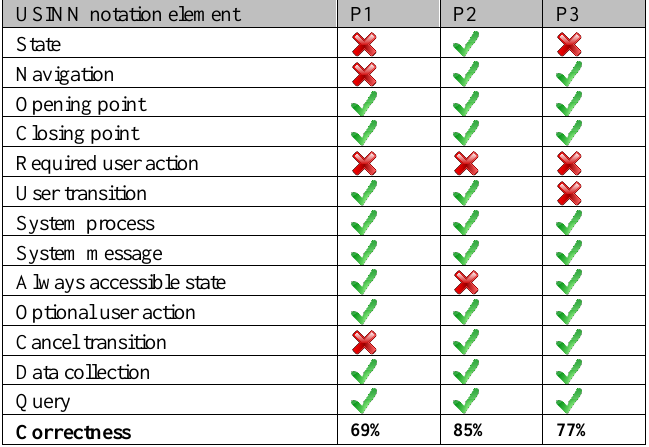
TABLE VIII. A NALYSIS OF THE C ORRECTNESS OF THE C REATED M ODELS .